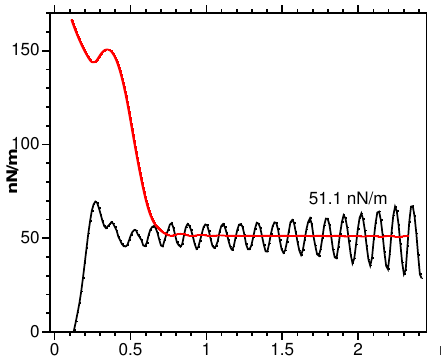
Figure 4. Run Bx: same as Fig. 2, but with B x = 30 000nT.